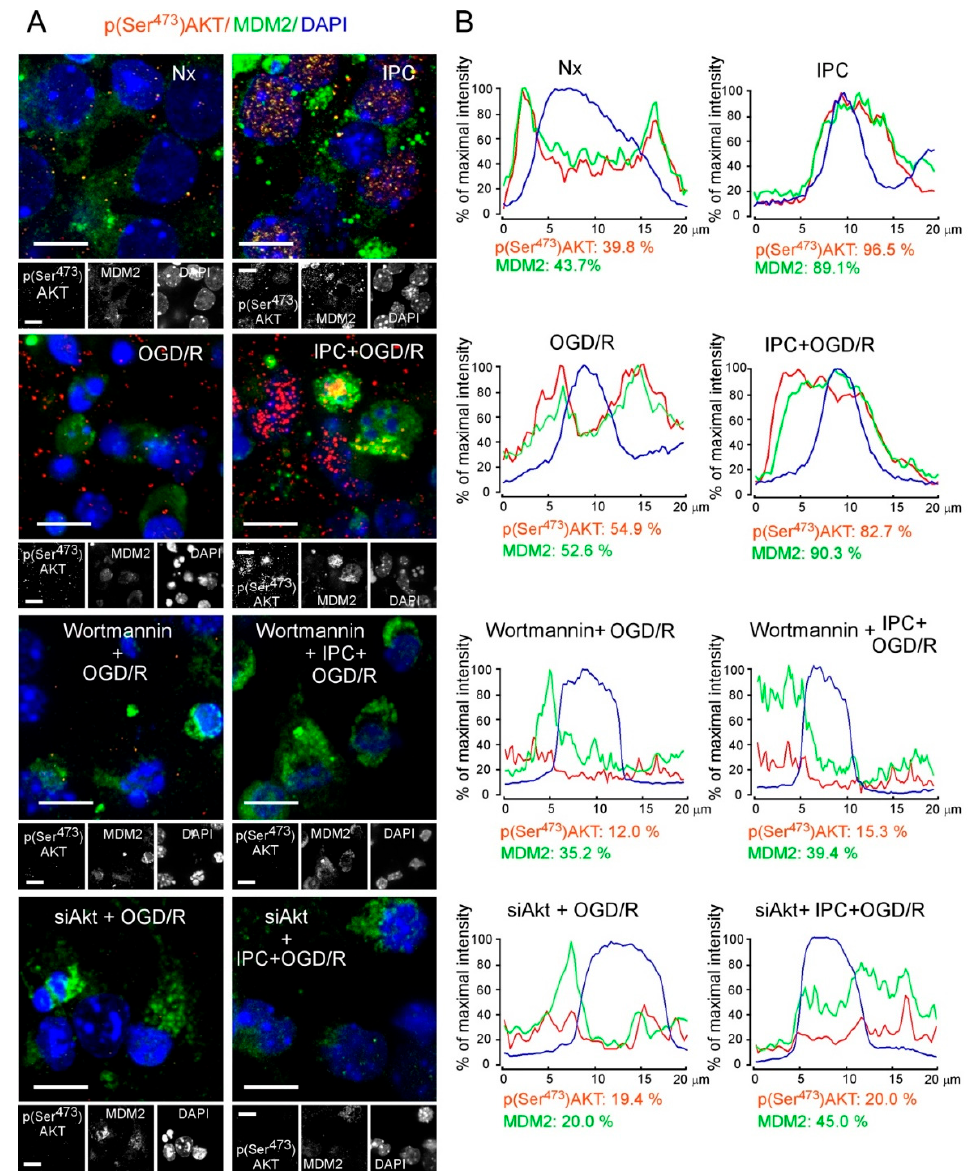
Figure 5. Disruption of IPC-promoted PI3K/AKT signaling pathway abrogates MDM2 nuclear translocation from the cytosol after ischemic injury. Neurons at 9–10 DIV were treated with wort- mannin for 30 min or at 6 DIV were transfected with siAkt for 72 h followed by Nx, IPC, OGD/R, and IPC + OGD/R protocols. Subcellular location of MDM2 and p(Ser 473 )AKT in neurons was analyzed by immunofluorescence. ( A ) Representative images of cortical neurons untreated or treated with wortmannin or siAKT, and stained with p(Ser 473 )AKT (red), MDM2 (green), and DAPI (blue, nuclear marker). Scale bar, 10 μ m. ( B ) Representative cross-sectional intensity profiles for endogenous MDM2 (green), p(Ser 473 )AKT (red), and DAPI (blue). Percentages of mean nuclear fluores- cence are indicated. Maximal fluorescence intensity of p(Ser 473 )AKT and MDM2 in the nucleus of untreated neurons is calculated from four different neuronal cultures and presented in Figure S2C. In the case of neurons treated with wortmannin and siAkt, the maximal fluorescence intensity of nuclear MDM2 from five different cultures of cortical neurons is shown in Figure S2D.